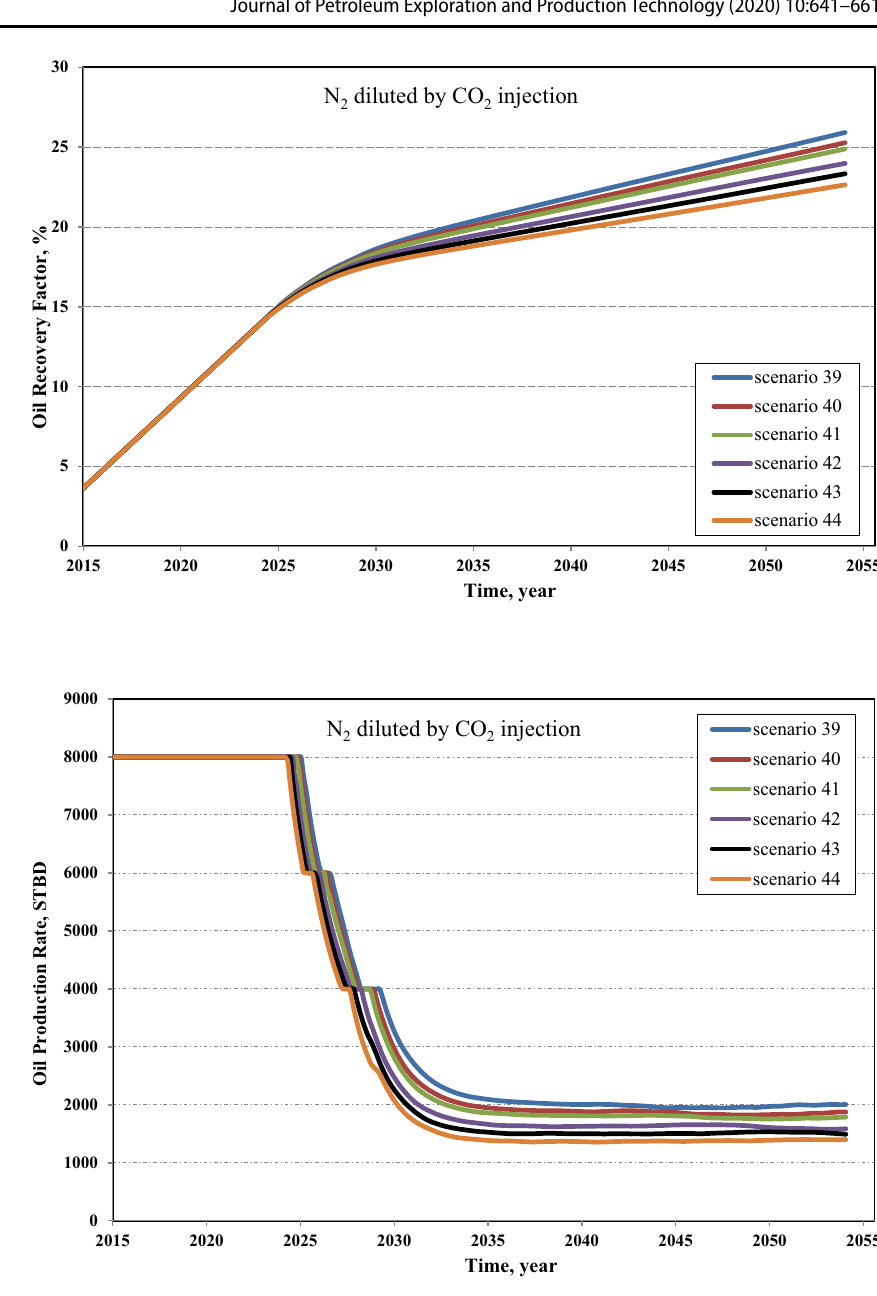
Fig. 16 Reservoir oil produc- tion rate for 50% N 2 –50% CO 2 mixture into different reservoir